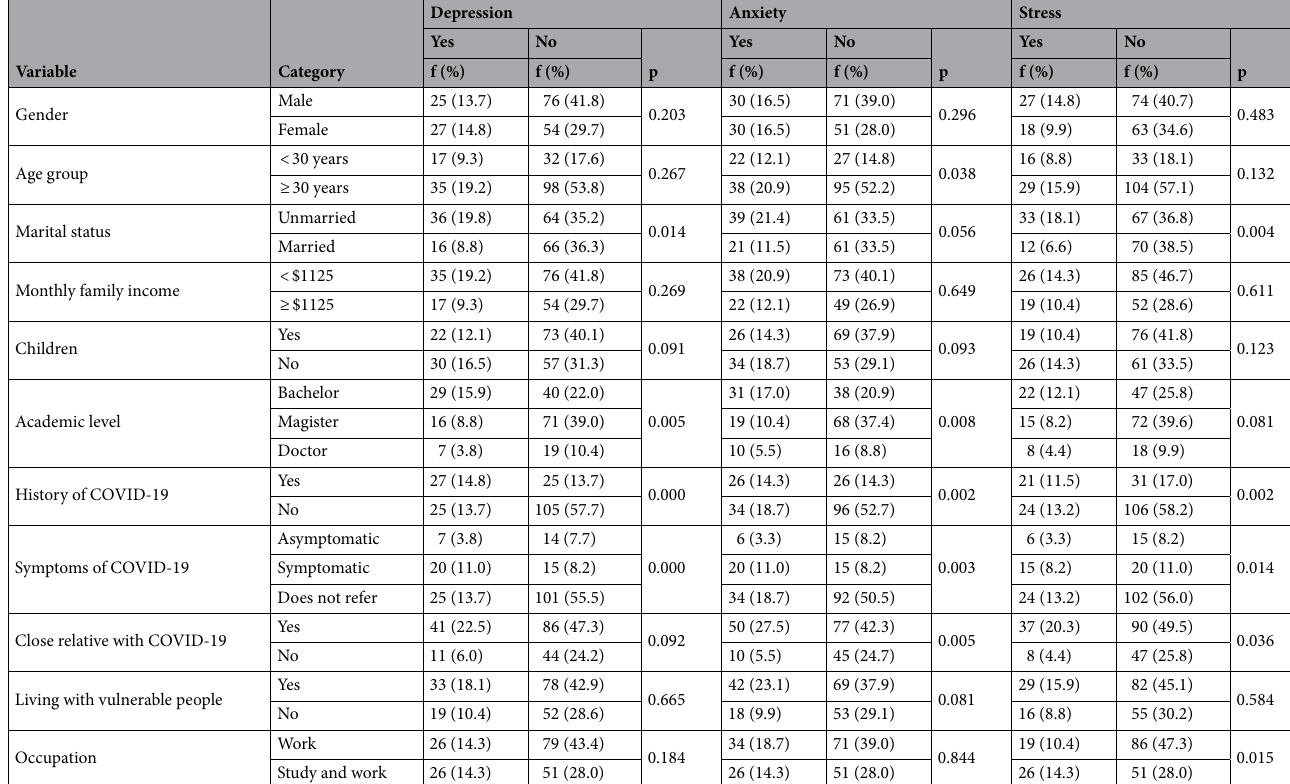
Table 4. Depression, Anxiety and Stress associated with sociodemographic factors of dental professionals in a Lima population during the second wave of COVID-19. *Based on Pearson’s chi-square, p < 0.05 (significant